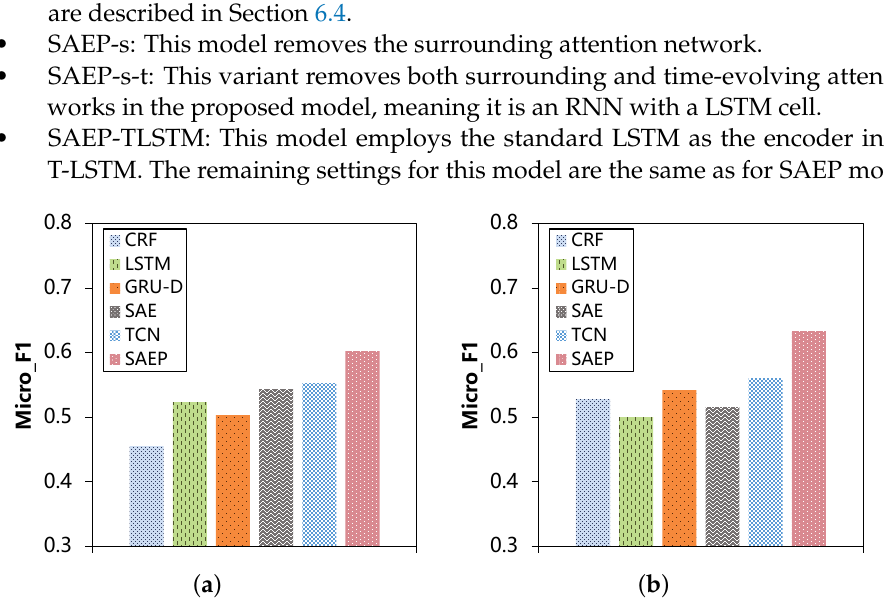
Figure 9. Emotion prediction results “micro F1” on two datasets. ( a ) Twitter; ( b )